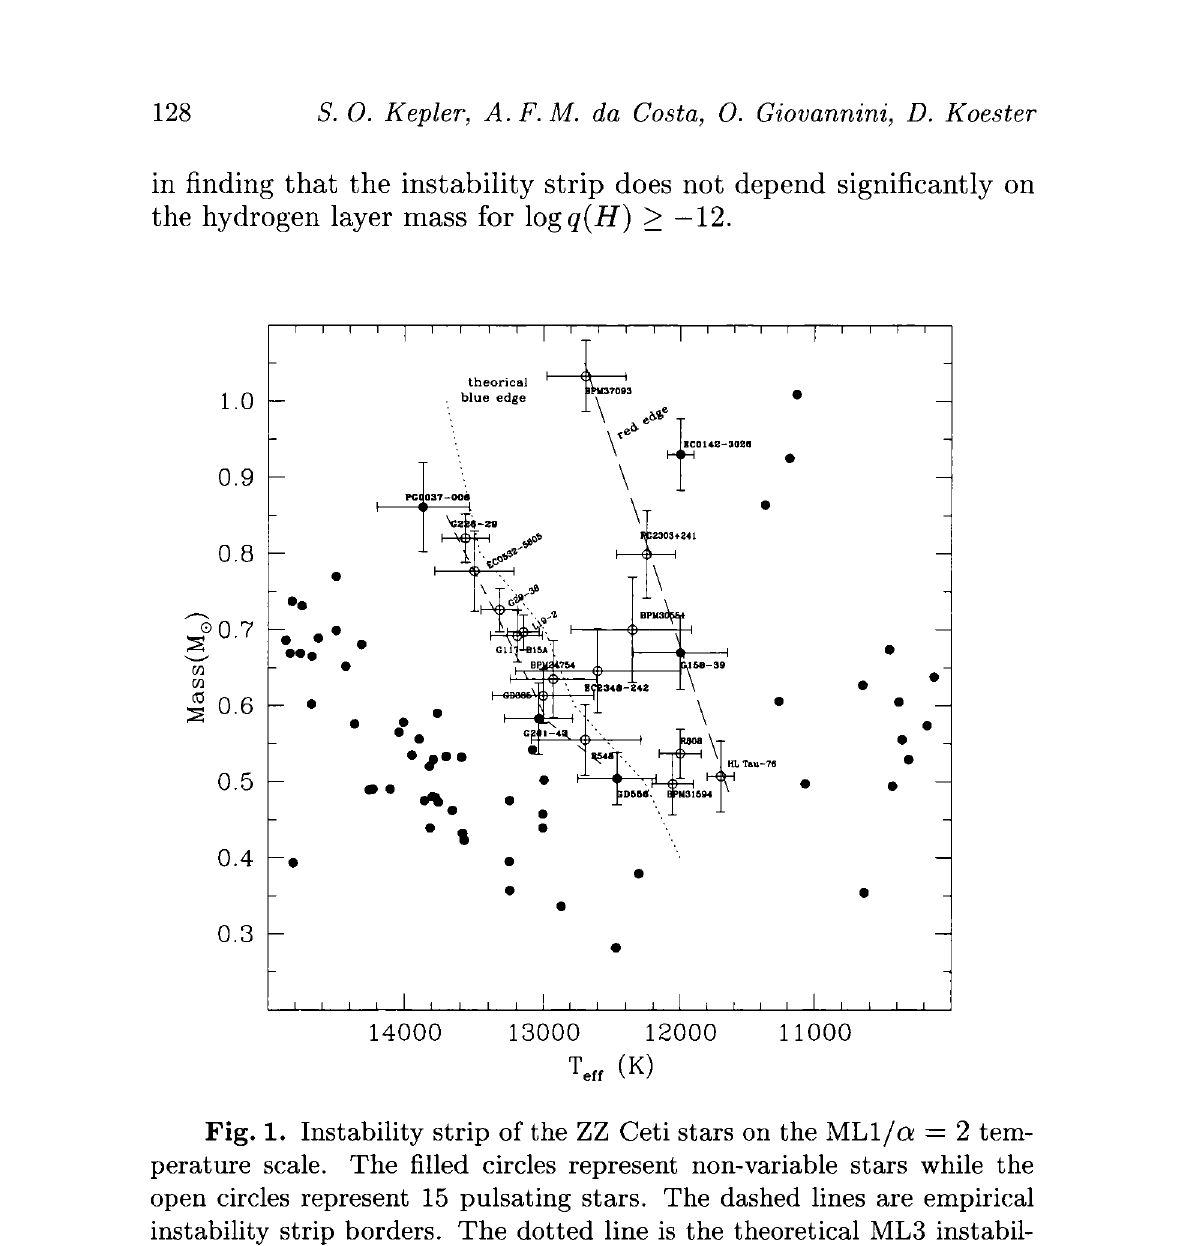
Fig. 1. Instability strip of the ZZ Ceti stars on the M L l /a = 2 tem- perature scale. The filled circles represent non-variable stars while the open circles represent 15 pulsating stars. The dashed lines are empirical instability strip borders. The dotted line is the theoretical ML3 instabil- ity strip of Bradley &; Winget (1994). No non-variable lies within this empirical